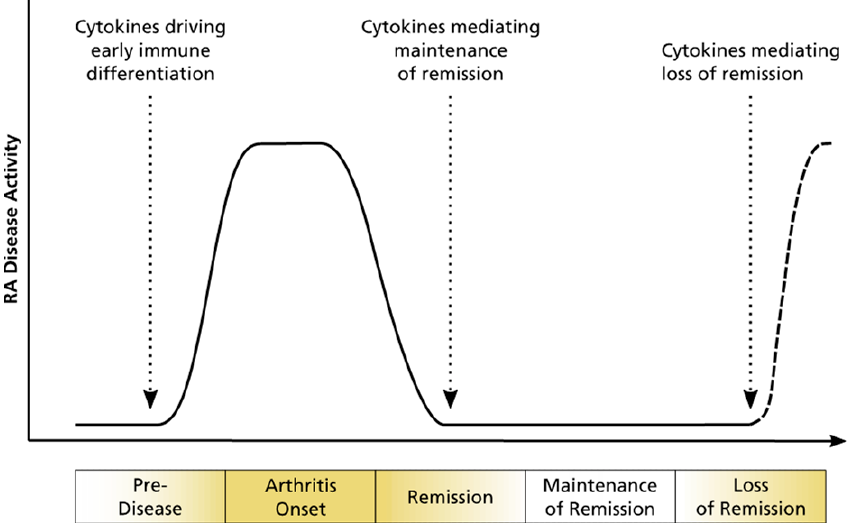
Figure 2. Schematic illustration of disease progression in RA with implied possible loss of remission. Adapted from Reference [13].